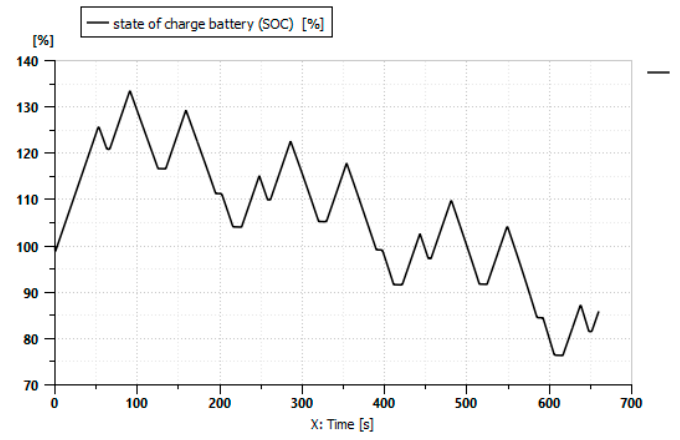
Figure 8. Battery’s state of charge.